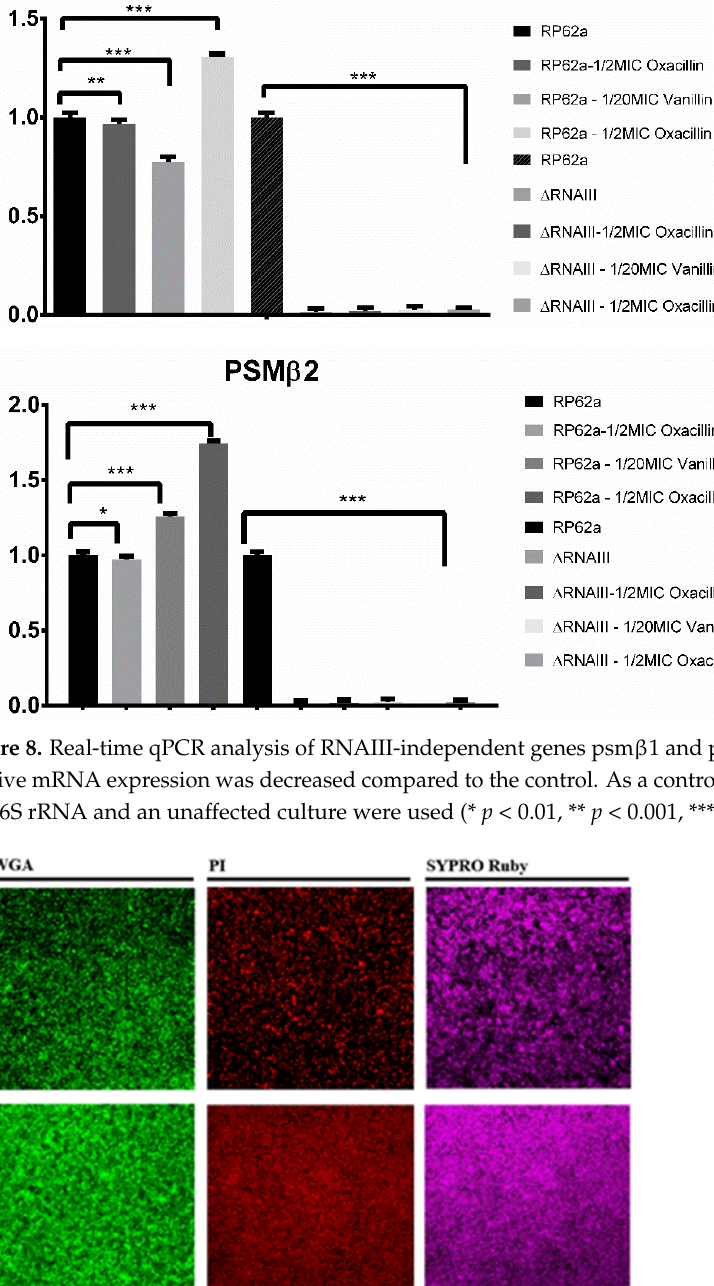
8 of 18 Figure 7. Real-time qPCR analysis of RNAIII-dependent genes agrD and agrA . For both genes, relative mRNA expression was lowered compared to control. As a control, a housekeeping gene